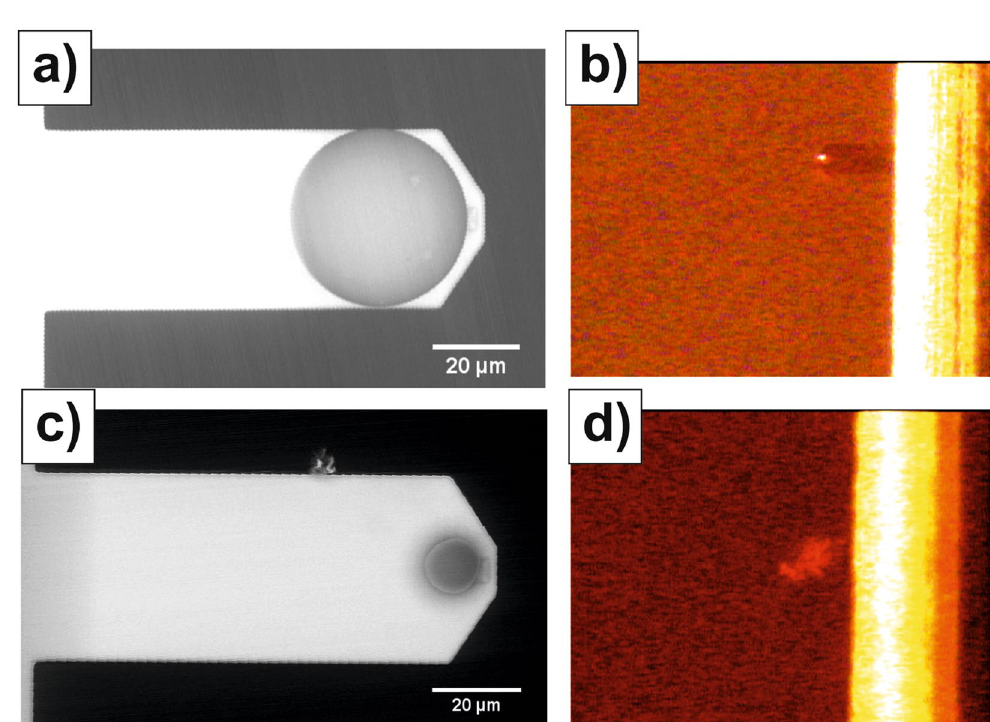
Figure 2. Role of probe size in the interaction with mucus blankets. (a ) Representative SEM image of the 40 µ m colloidal probes used in this study (the actual diameters were always determined from the analysis of the SEM images). ( b ) Optical image registered when the probe shown in ( a ) established contact with ileum mucosa at a repulsive force of 10 nN. (c) Representative SEM image of the 15 µ m colloidal probes used in the study. ( d) Optical image registered when, while approaching ileum mucosa with the probe shown in ( c ), the signal registered by the PSD dropped to